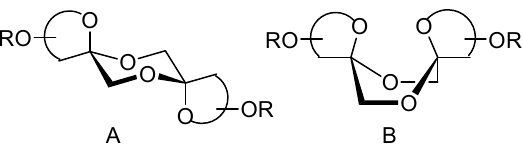
Figure 7 . Conformations at the central dioxane ring for non-symmetric (A) and C symmetric (B) DFAs.